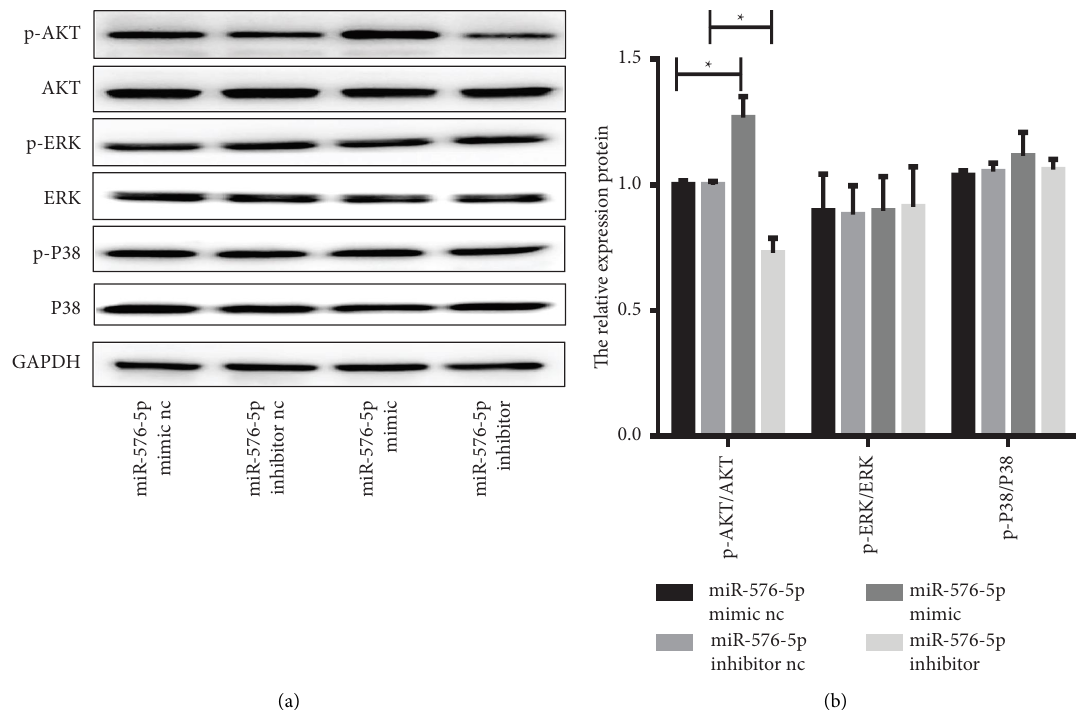
Figure 3: miR-576-5p correlated positively with phosphorylated AKT. Phosphorylation of AKT, ERK, and P38 was examined in TPC-1 cells by western blotting. ∗ P < 0 . 05.